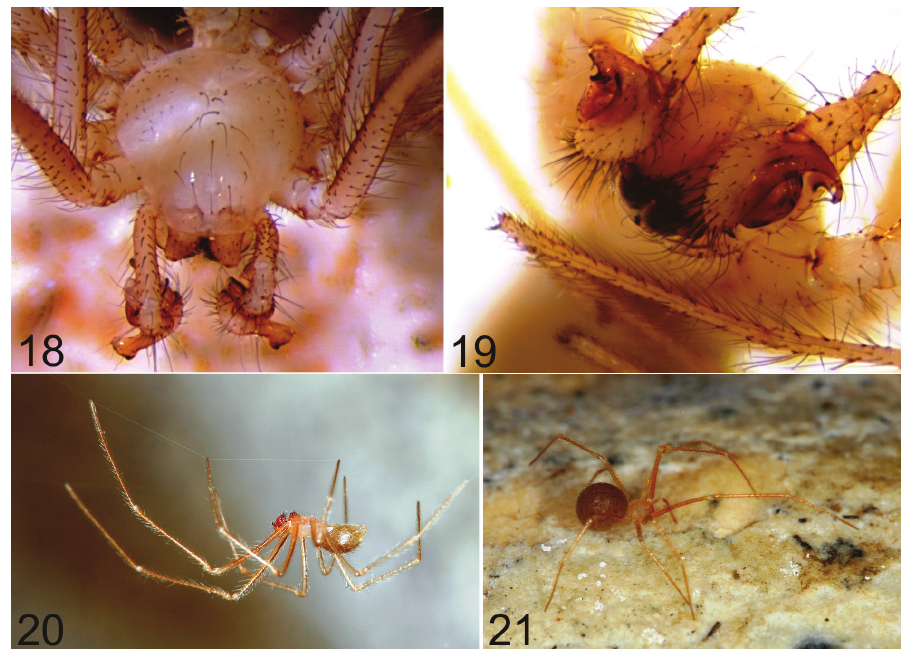
Figures 18–21. Typhlonesticus gocmeni sp. n. 18–19 male, prosoma 18 dorsal view 19 frontal view 20 male in the web 21